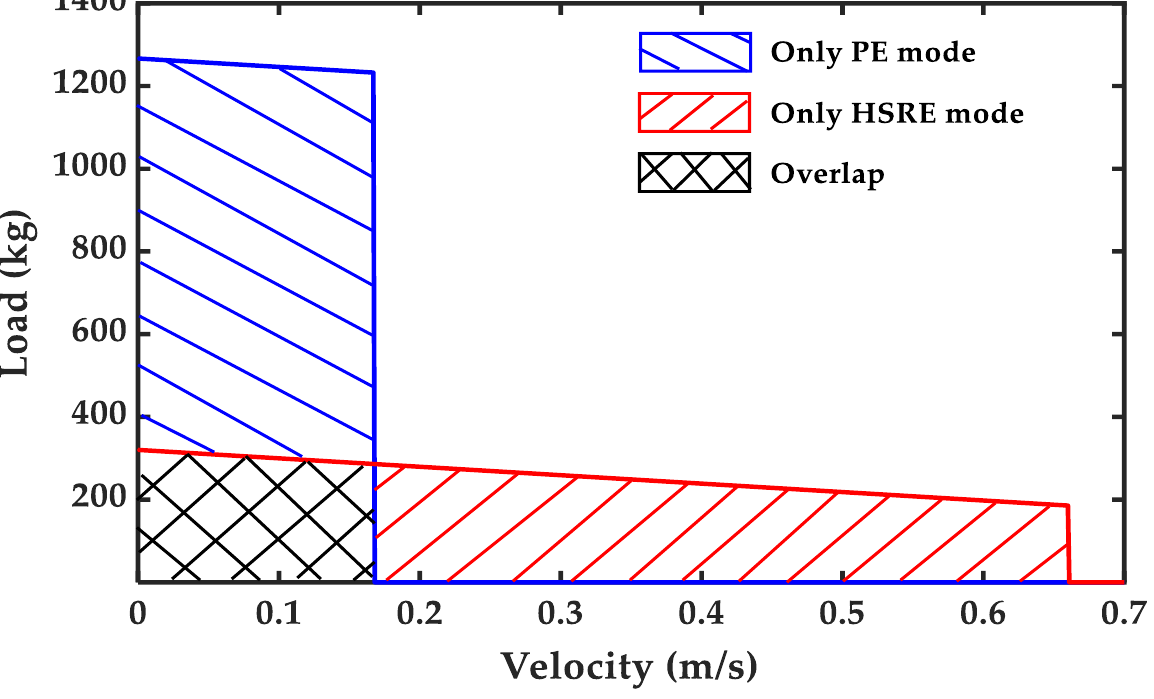
Figure 8. The load-velocity curve for switching mode on extension mode of NIMV system.